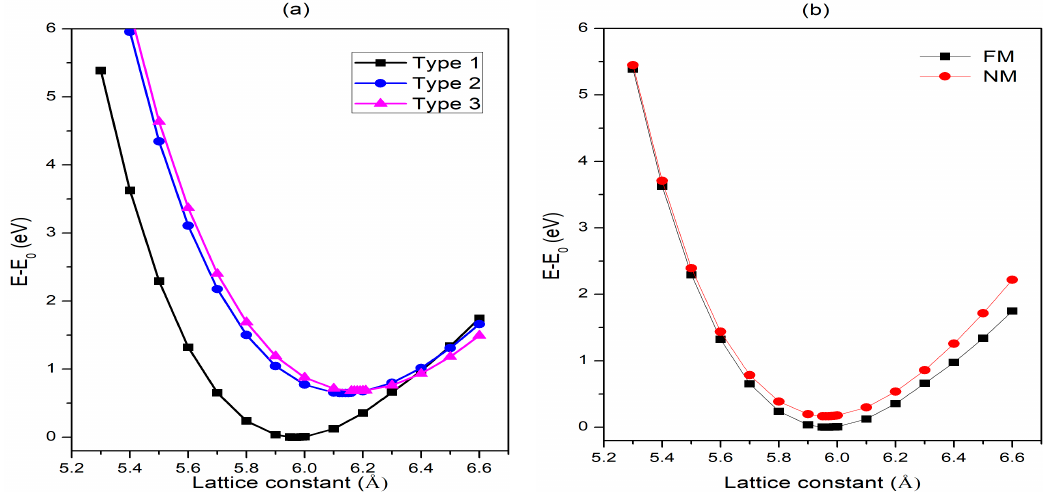
Figure 3. Total-energy-lattice-constant curves of the ScFeRhP compound in ferromagnetic (FM) states for the type ( a ) 1, 2, and 3 structures, and ( b ) FM and non-magnetic (NM) states for type 1.